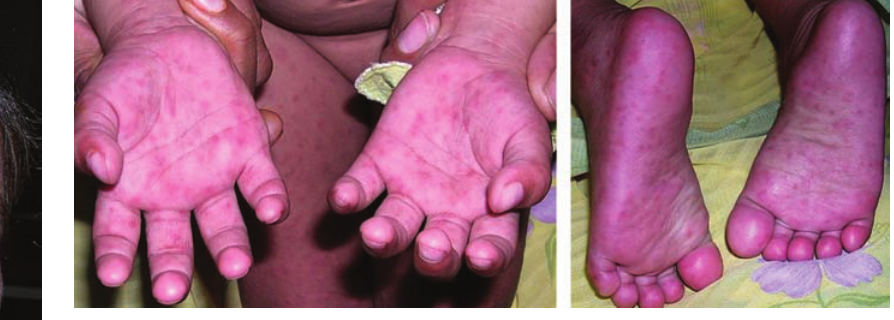
Figure 7. Typical lesions of papular purpuric gloves and socks syndrome in an Indian